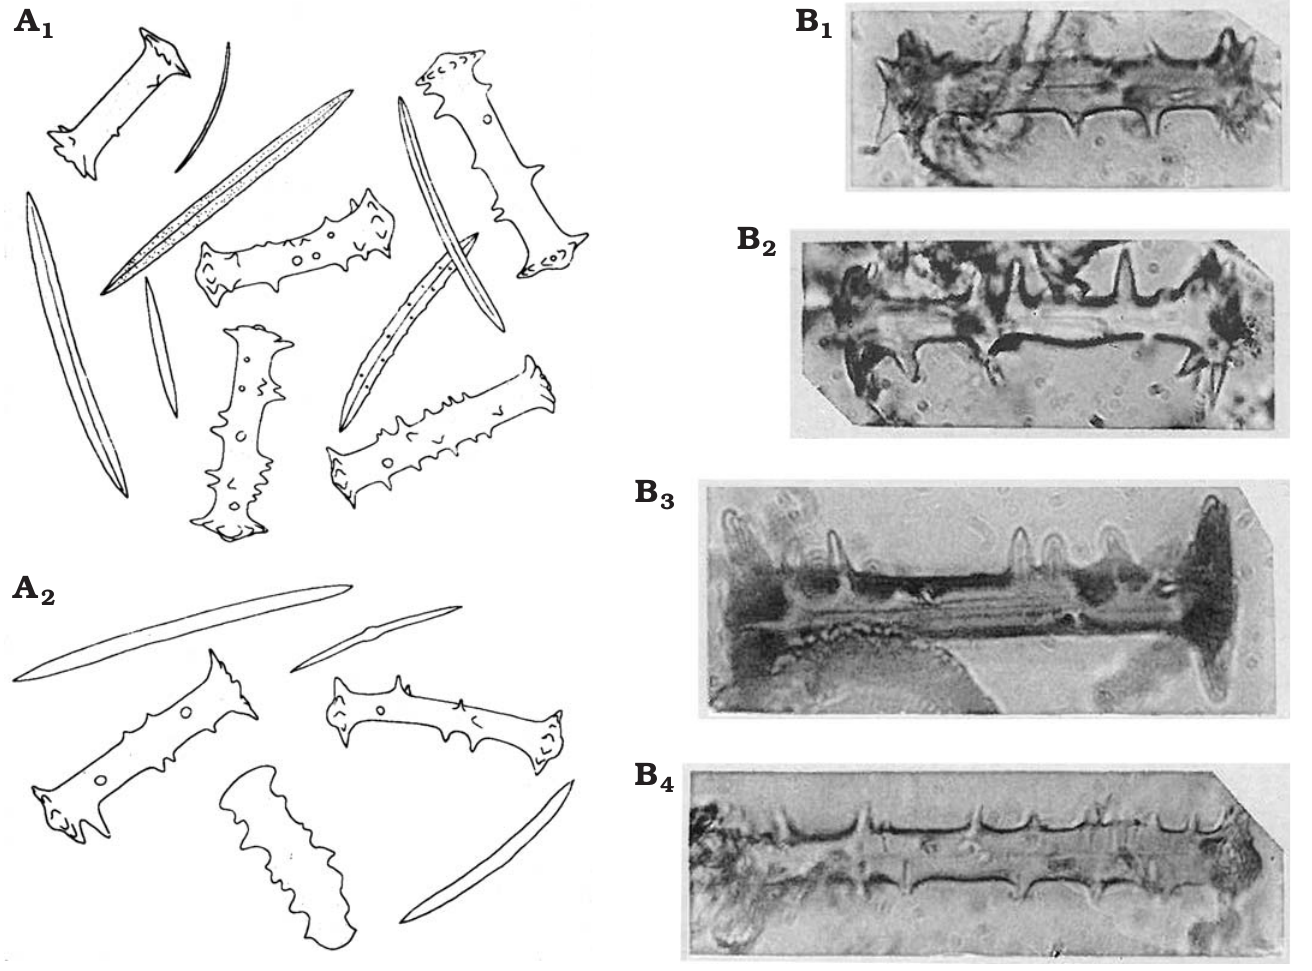
Fig. 21. Ephydatia fossilis Traxler, 1894, Spongillida: Spongillidae. A . Drawings of oxeas (megascleres) and birotules (gemmuloscleres). Originally not to scale; from the text it may be inferred that the birotules are between 41 and 67 μ m long, and oxeas are 160 to 350 μ m long; material from the Bory site (A 1 ) and from the Dubrovica site (A 2 ). B . Birotules with spiny shaft (gemmuloscleres); from Chambon, Central France. Birotules are 65–69 μ m long. Modified from: A, Traxler (1894); B, Firtion